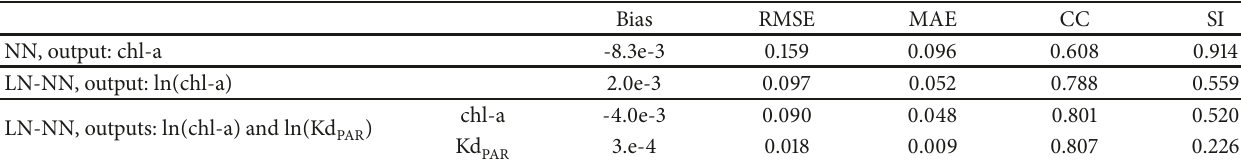
Figure 13: Cross-correlation of monthly mean chl-a fields: (a) LN-NN versus VIIRS (2012–2014), (b) NN versus VIIRS (2012–2014), (c) LN-NN versus SeaWiFS (2005–2010), and (d) NN versus SeaWiFS (2005–2010). Table 2: Comparison of error statistics: bias, RMSE, mean absolute error(MAE), correlationcoefficientor cross-correlation(CC),and scatter index (SI) on an independent validation set for three NN ensembles: (i) ensemble of NNs with one output (chl-a), (ii) ensemble of LN-NNs with one output (ln(chl-a)), and (iii) ensemble on LN-NNs with two outputs, ln(chl-a) and ln(Kd PAR ). All NNs have 23 inputs and 30 hidden